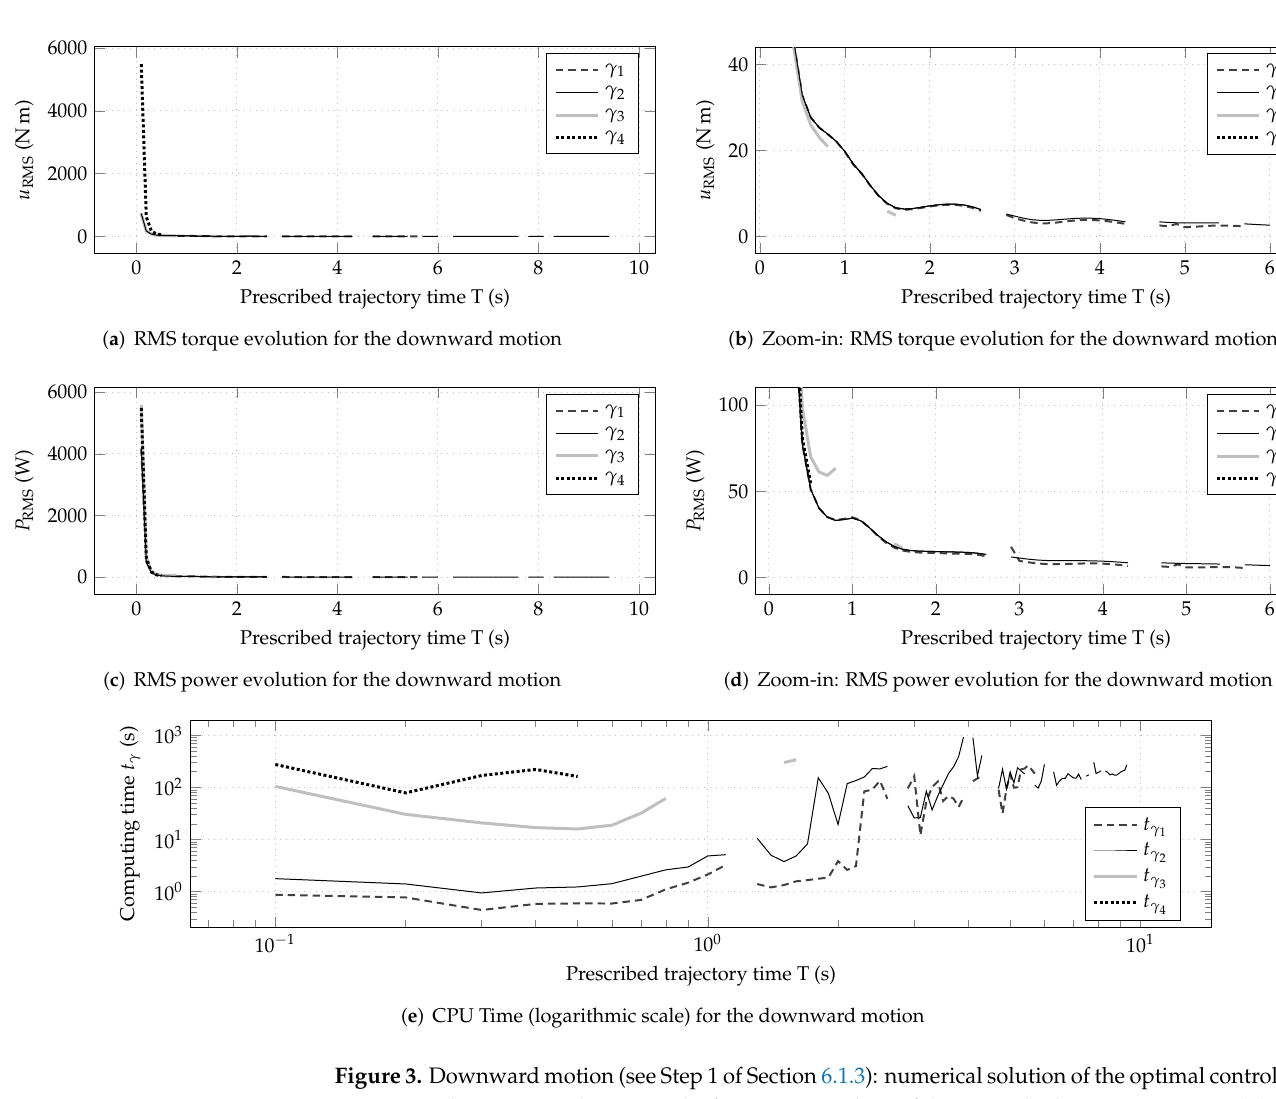
Figure 3. Downward motion (see Step 1 of Section 6.1.3): numerical solution of the optimal control of a two DOF robotic manipulator. Results for growing values of the prescribed trajectory time T : ( a ) RMS torque evolution; ( b ) cropped and zoomed-in version of ( a ); ( c ) RMS power evolution; ( d ) cropped and zoomed-in version of ( c ); ( e ) required time to compute a solution. Benefits of our invariant cost functions γ 1 and γ 2 : lower RMS power values; improved solver stability with uninterrupted results up to T = 5.7s for γ 1 and up to T = 9.5s for γ 2 ; substantially lower computing